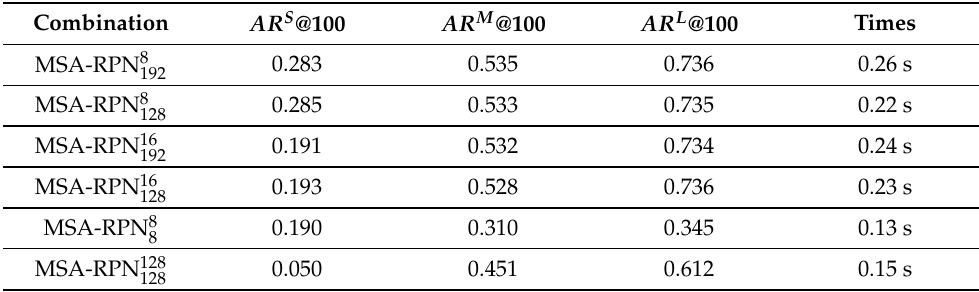
Table 5. Results of different combinations of scales on the LEVIR